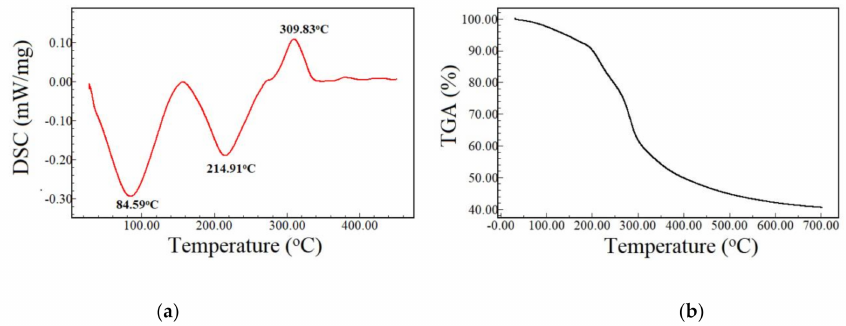
Figure 3. Differential scanning calorimetry (DSC) ( a ) and thermogravimetric analysis (TGA) ( b ) curves of aloe vera extract.